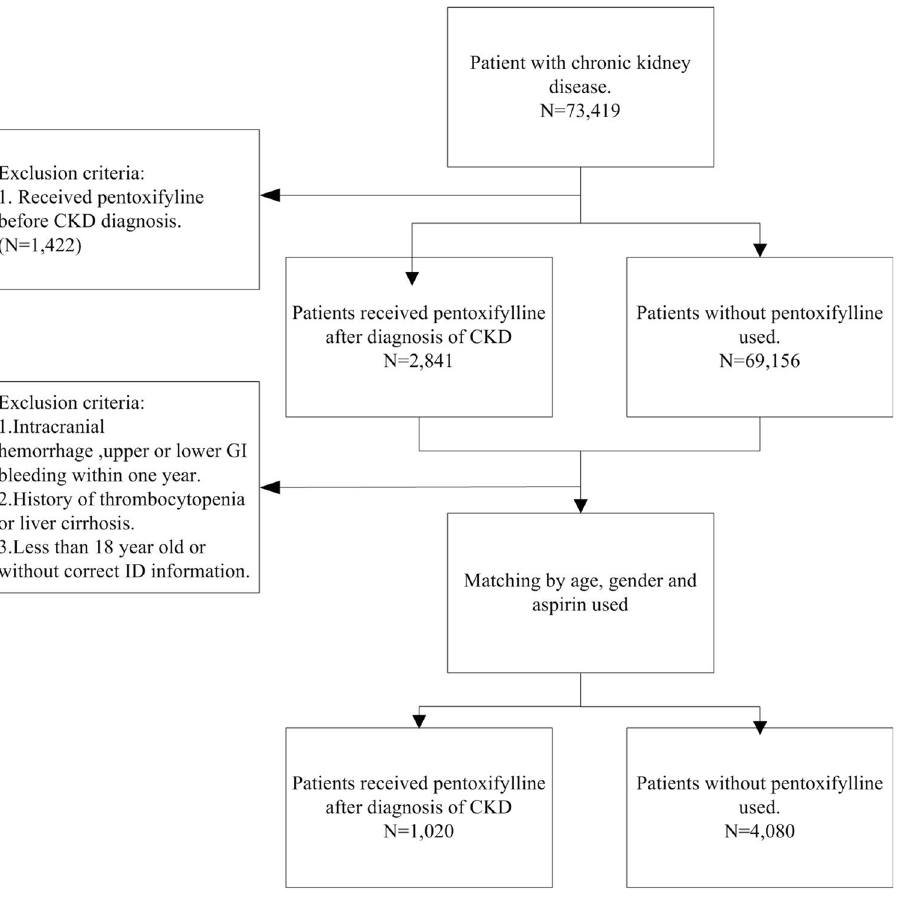
Figure 1. Flowchart of patient